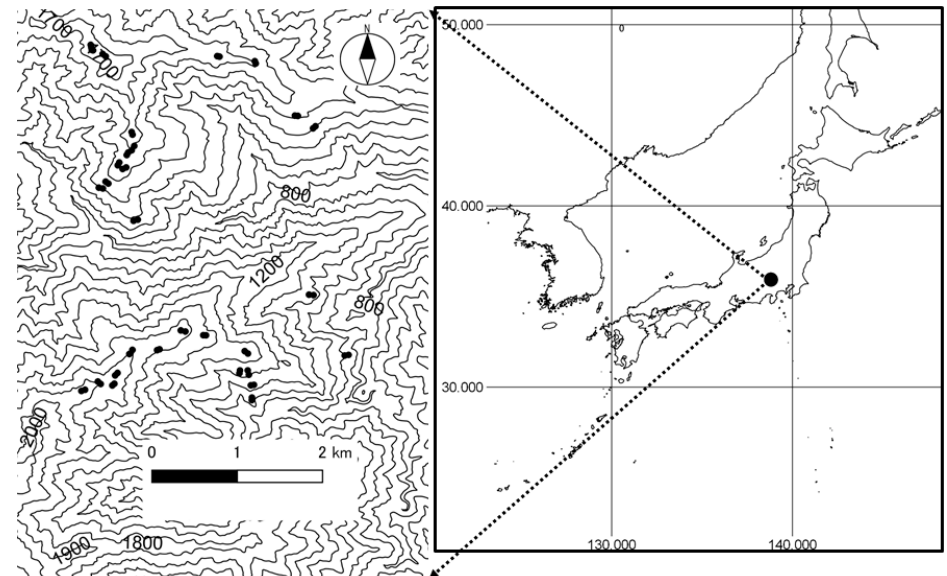
Figure 1. Locations of plots in the University of Tokyo Chichibu forest (35°55 ′ N, 138°50 ′ E), Chichibu City, Saitama Prefecture, central Japan. In the topographic map (left), solid circles represent plots, and the contour interval is 100 m.